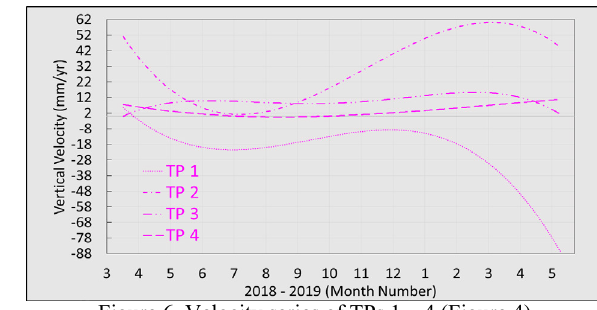
Figure 6. Velocity series of TPs 1 – 4 (Figure 4)